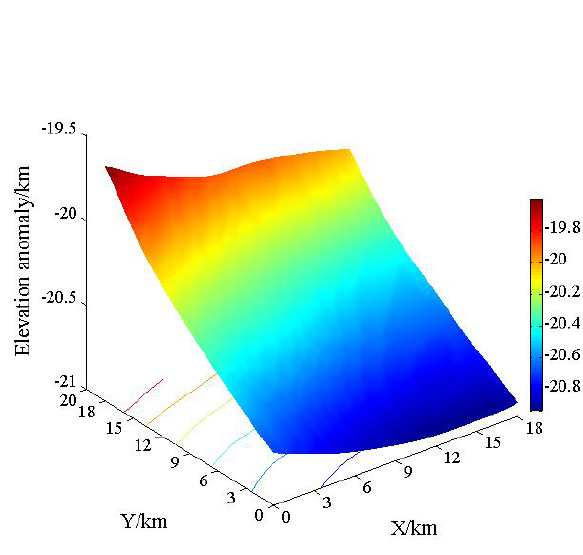
Figure 2. Known height anomaly fitting surface